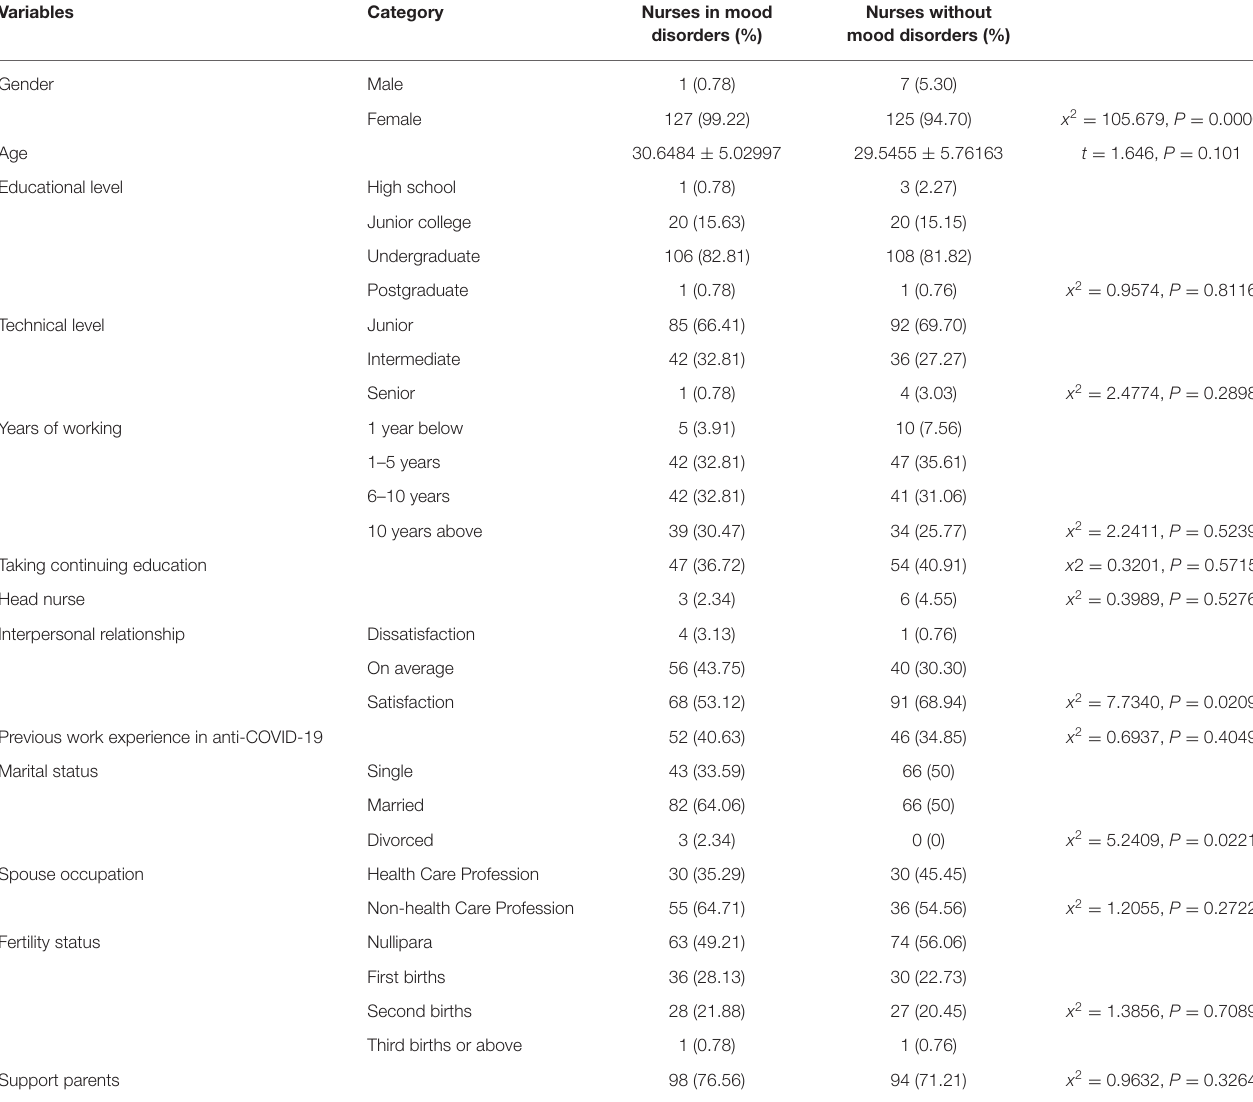
TABLE 2 | Demographic and social factors among neonatal nurses in mood disorders.